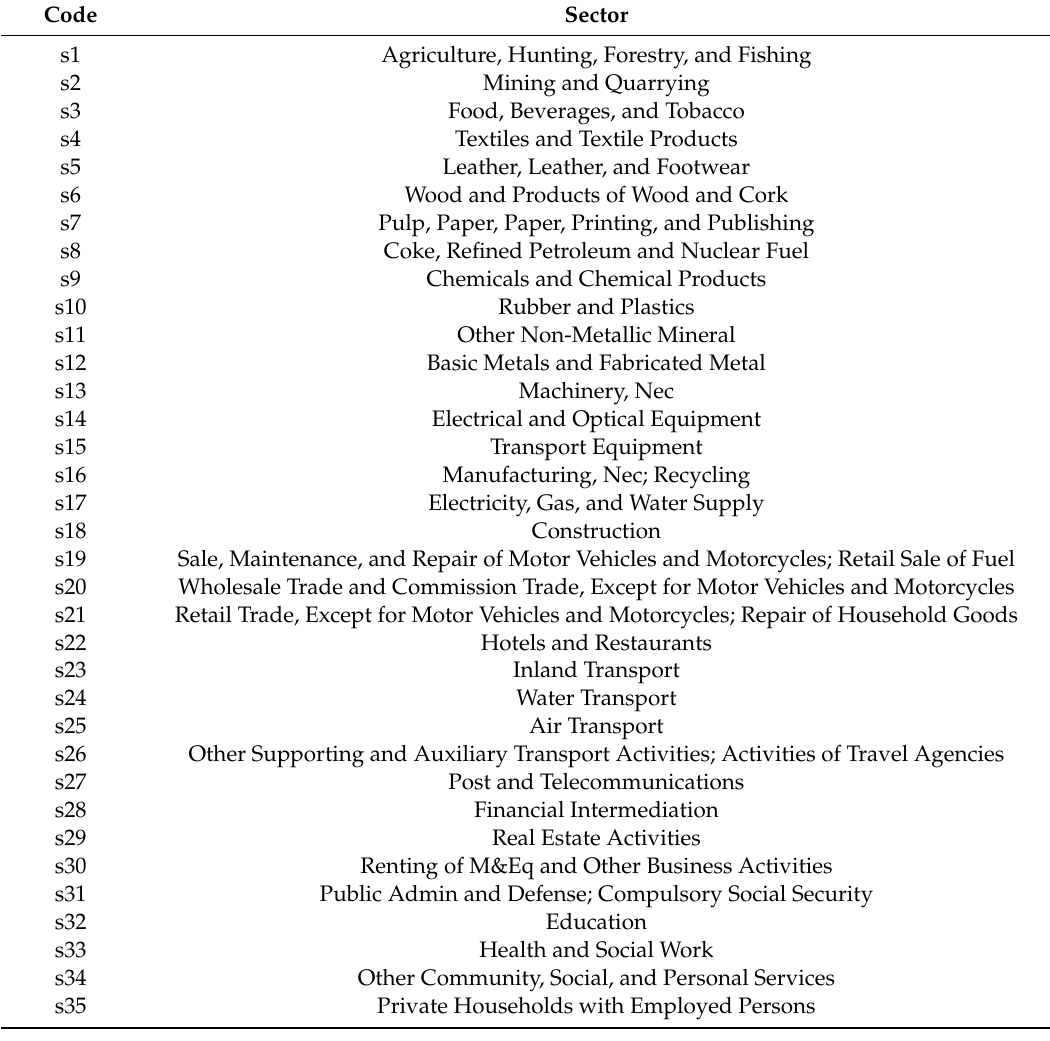
Table A1. Category of sectors in the World Input-Output